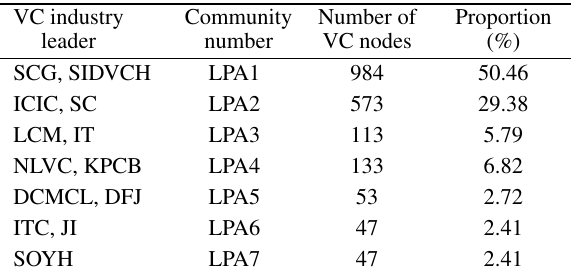
Table 3 Semi-supervised community detection results of LPA algorithm.